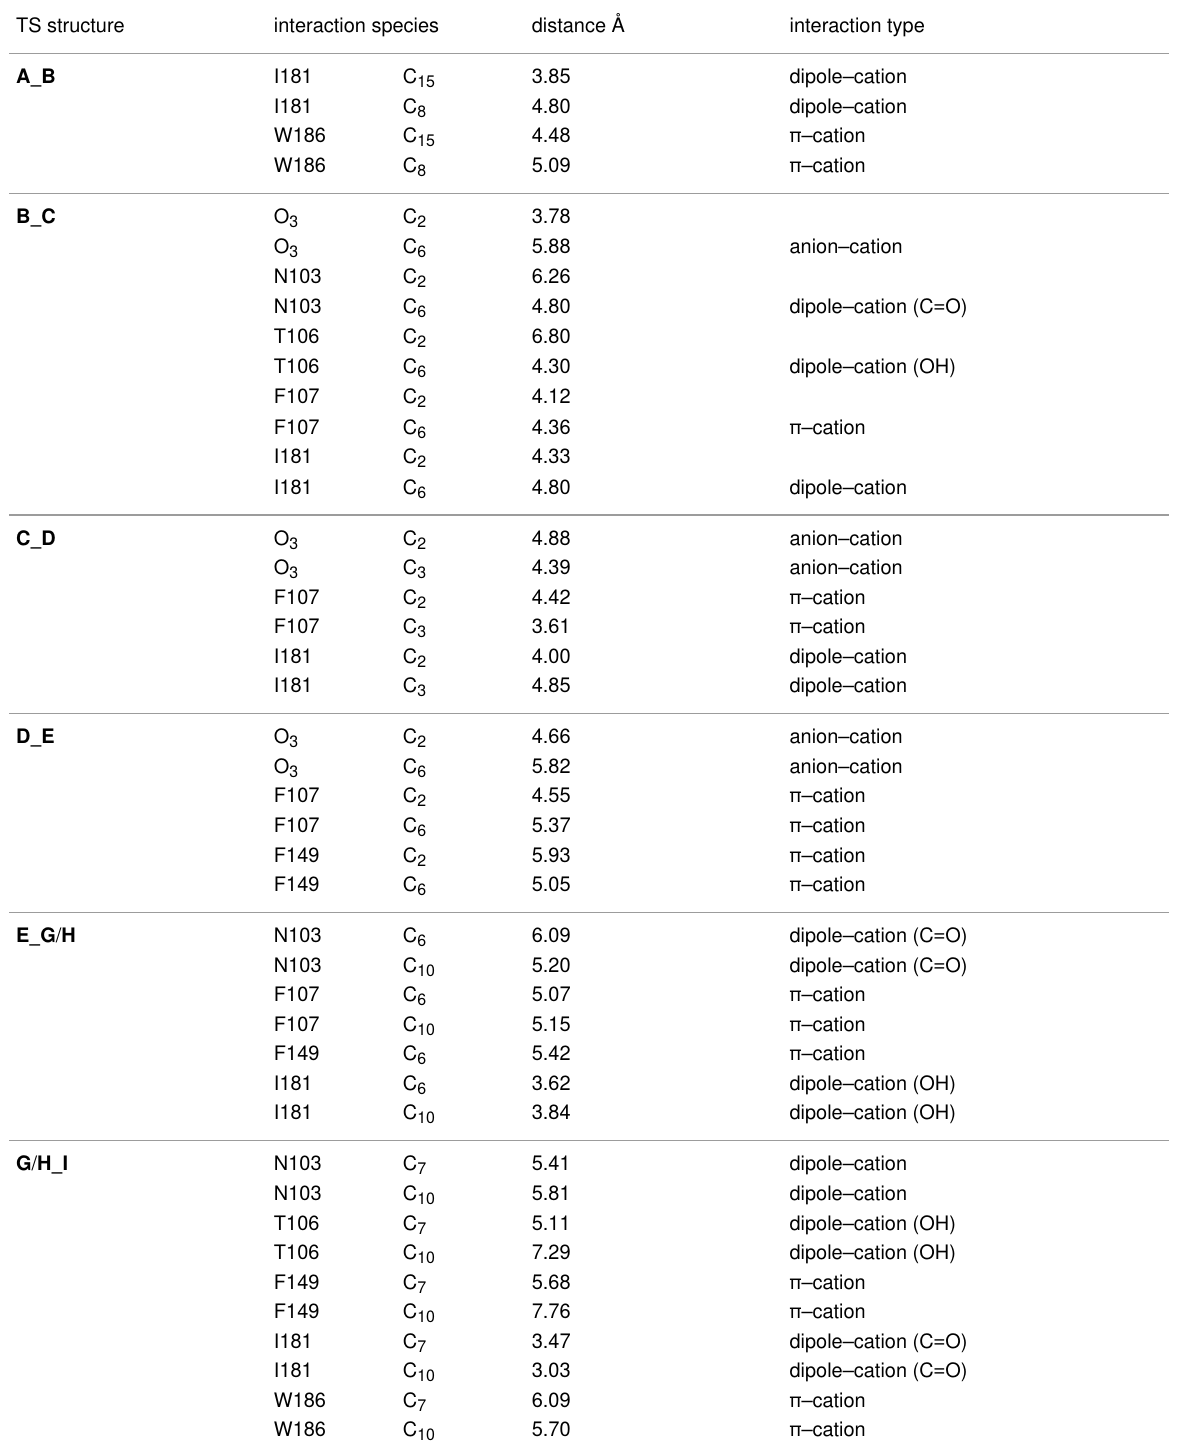
Table 1: Interactions between intermediates and TS structures with active site residues. (continued) TS